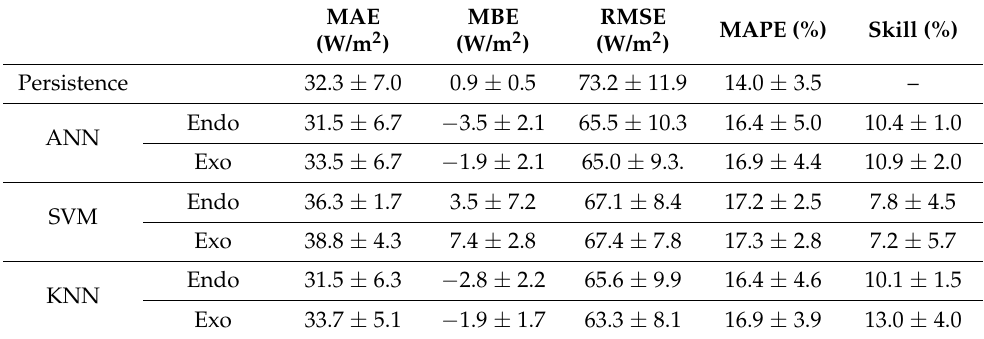
Table 2. Average GHI forecasting results over all horizons in mean ± standard deviation